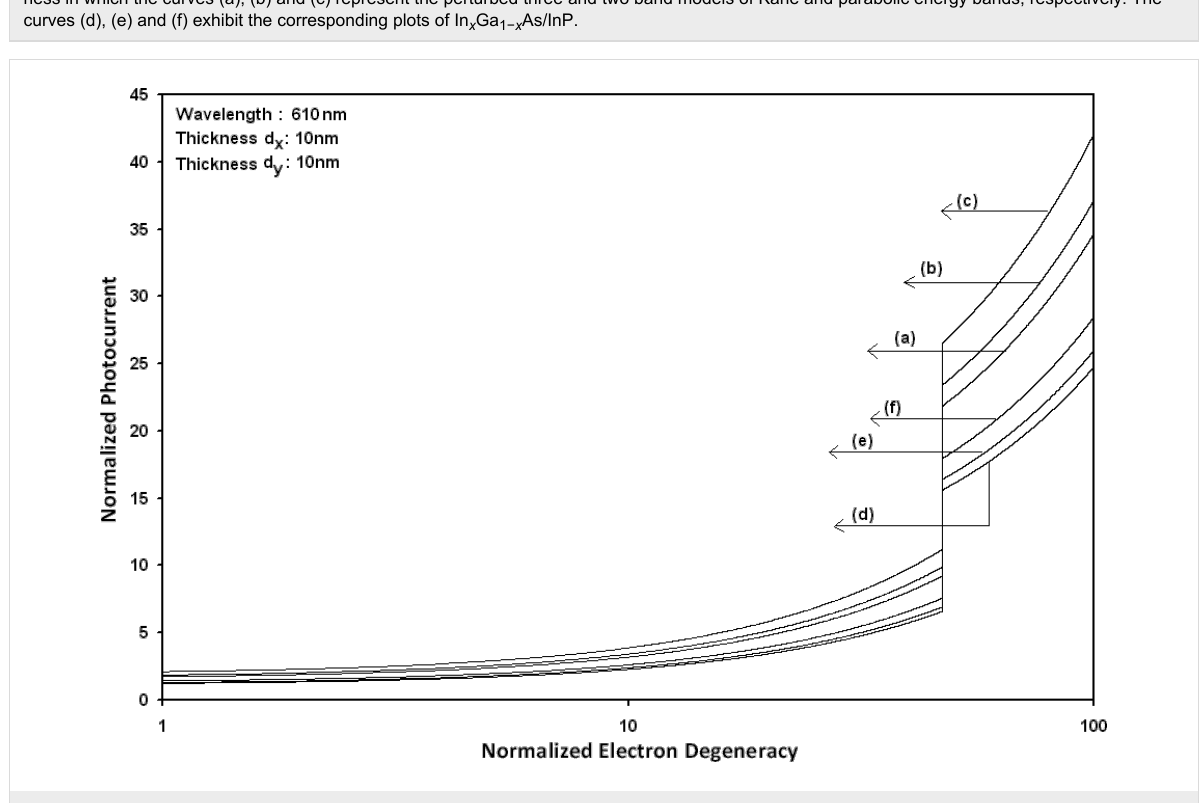
Figure 7: Plot of the normalized photocurrent from quantum well wire effective mass superlattices of HgTe/Hg 1 − x Cd x Te and In x Ga 1 − x As/InP as a function of normalized electron degeneracy for all cases of Figure